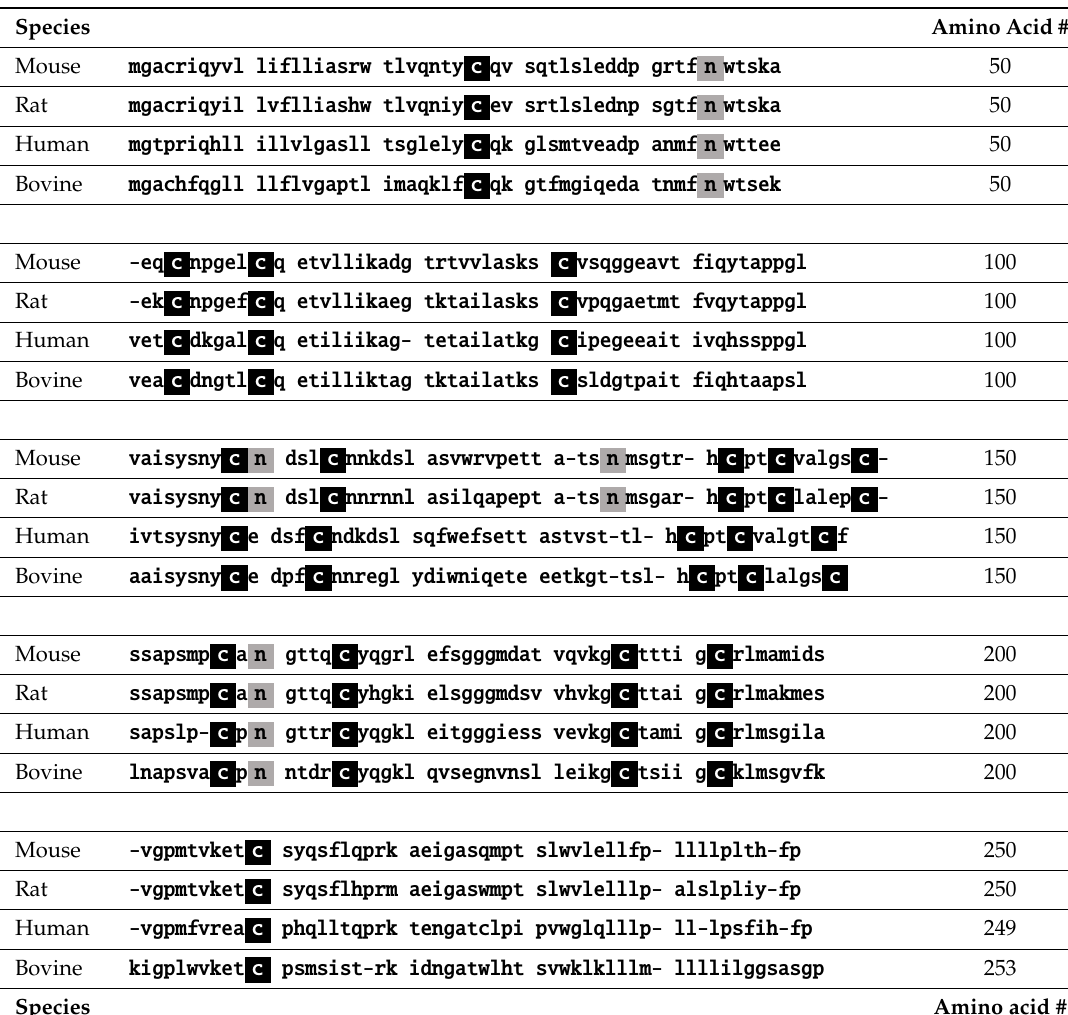
Table 2. The primary structure of TEX101 in major mammalian